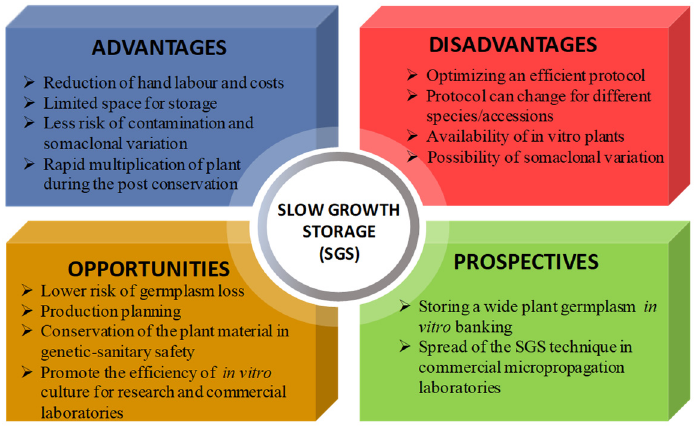
Figure 2. In vitro slow growth storage (SGS) technique as a competitive tool to make the plant con- servation dynamic and applicable in present and